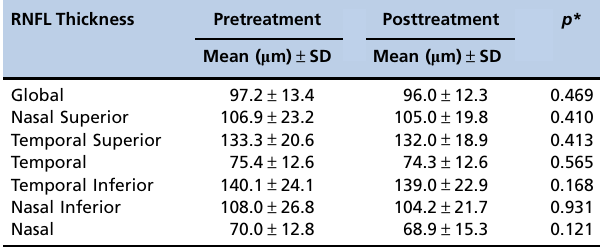
Table 2 - Average retinal nerve fiber layer (RNFL) thickness measures by spectral-domain optical coherence tomography before and 1 year after panretinal photocoagulation (n=38).